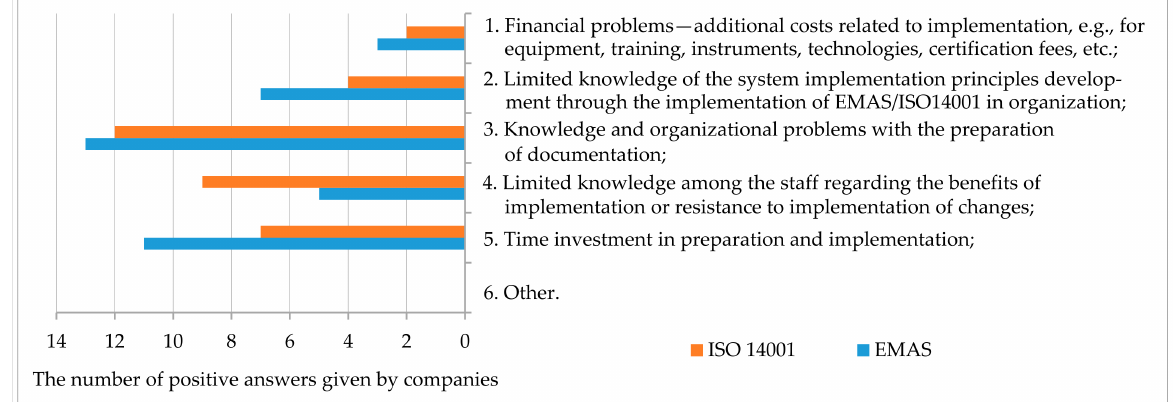
Figure 2. Answers to the second question of the survey: Difficulties encountered during EMAS/ISO14001